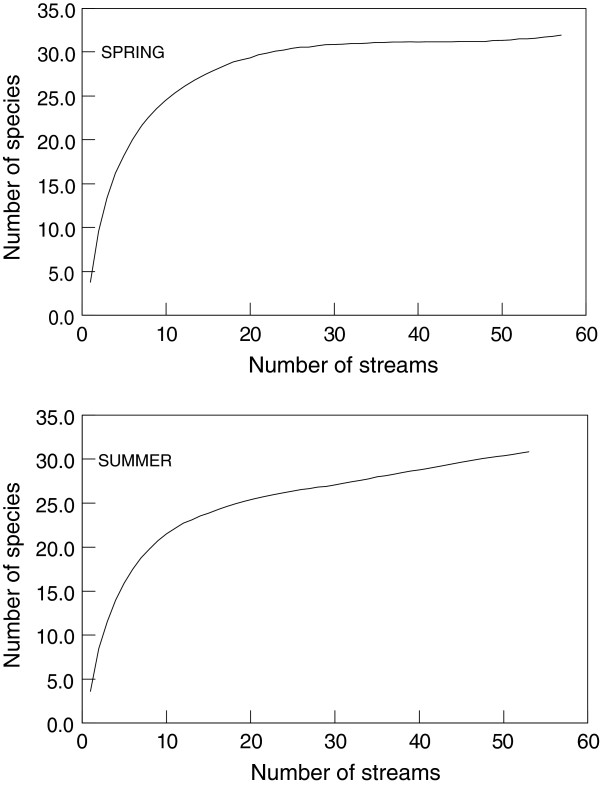
Species accumulation curves for larval black flies in spring and summer collections in South Carolina, USA.